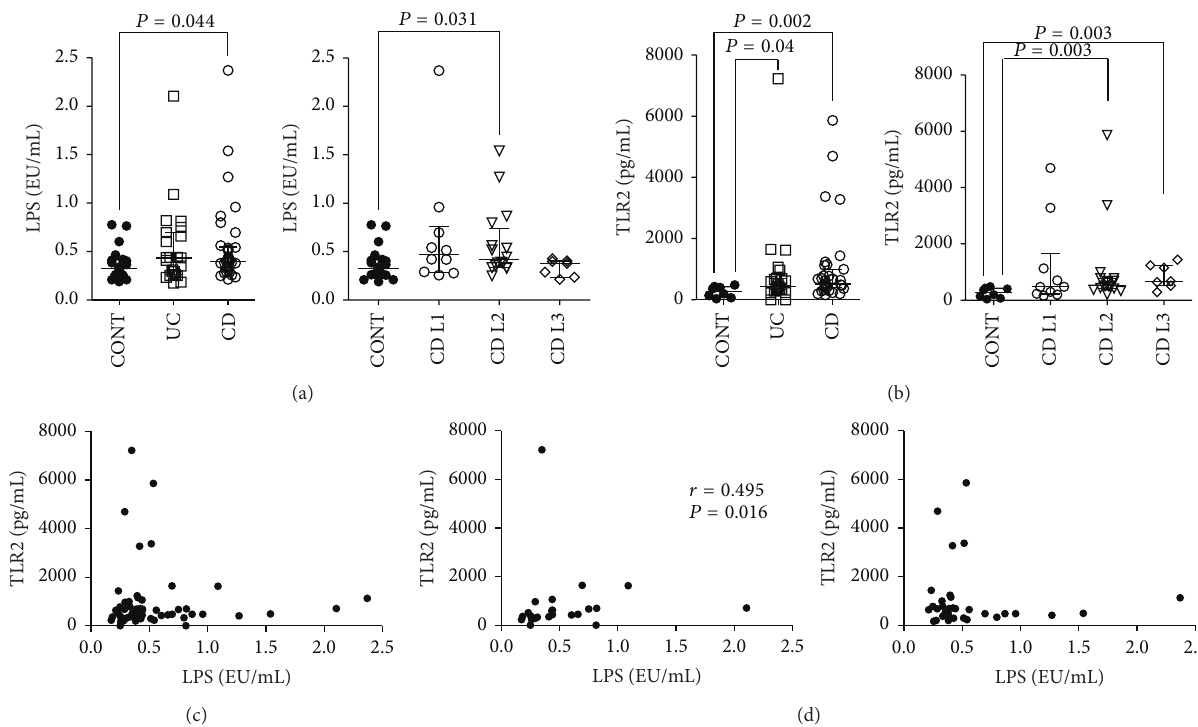
Figure 1: Circulating LPS and TLR2 are increased in IBD and correlate with each other in UC. Concentrations of LPS and TLR2 were measured in the sera of IBD (both UC and CD) patients and healthy controls (CONT). (a) LPS serum levels in CONT, UC, and CD patients (left panel) and CD locations according to Montreal classification (right panel). (b) TLR2 serum levels in CONT, UC, and CD patients (left panel) and CD locations according to Montreal classification (right panel). (c) Correlation between circulating levels of LPS and TLR2 in IBD patients. (d) Correlation between circulating levels of LPS and TLR2 in UC (left panel) and CD (right panel) patients. Horizontal bars in (a) and (b) represent median and interquartile range. Statistical analysis was performed by means of Mann-Whitney Test and Spearman Correlation Test. 𝑃 < 0.05 was considered statistically significant.